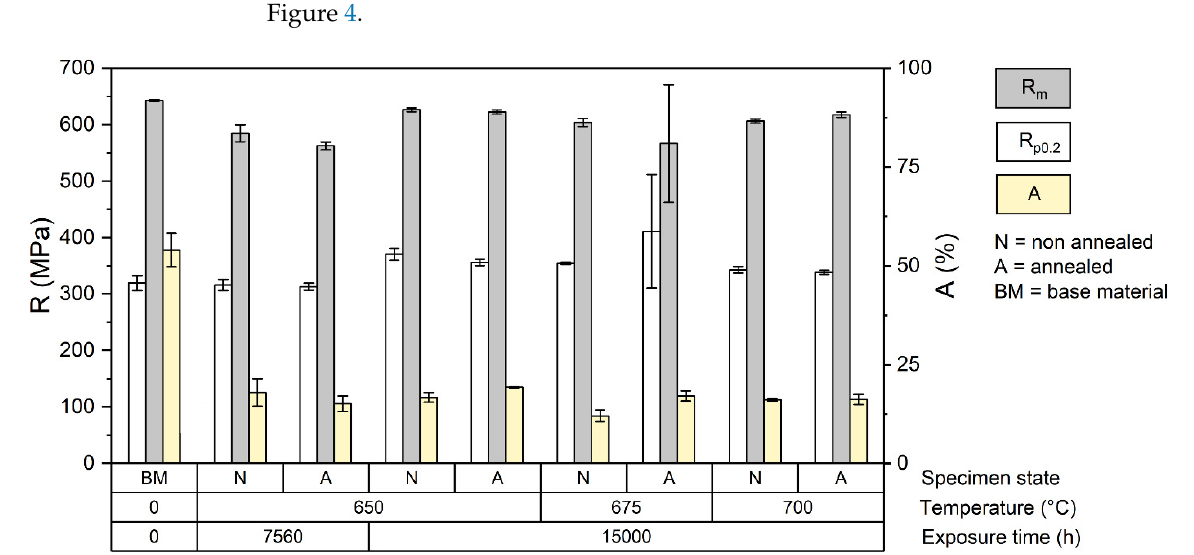
Figure 3. Macrograph of the homogeneous weld, without heat treatment, immersion etched in Glyceregia.